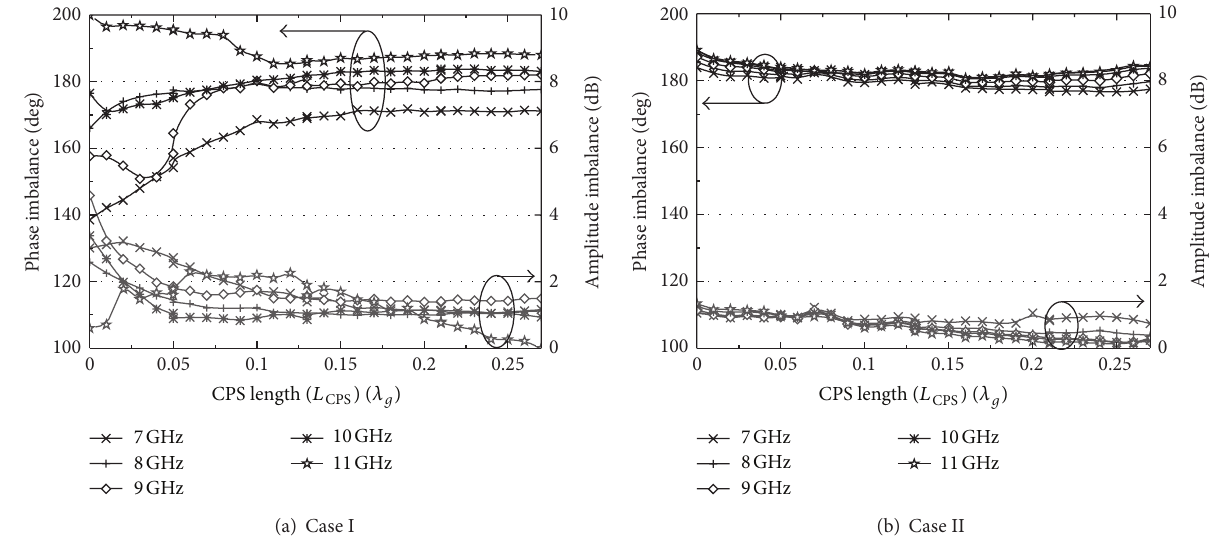
Figure 5: Amplitude and phase imbalances as a function of CPS length.